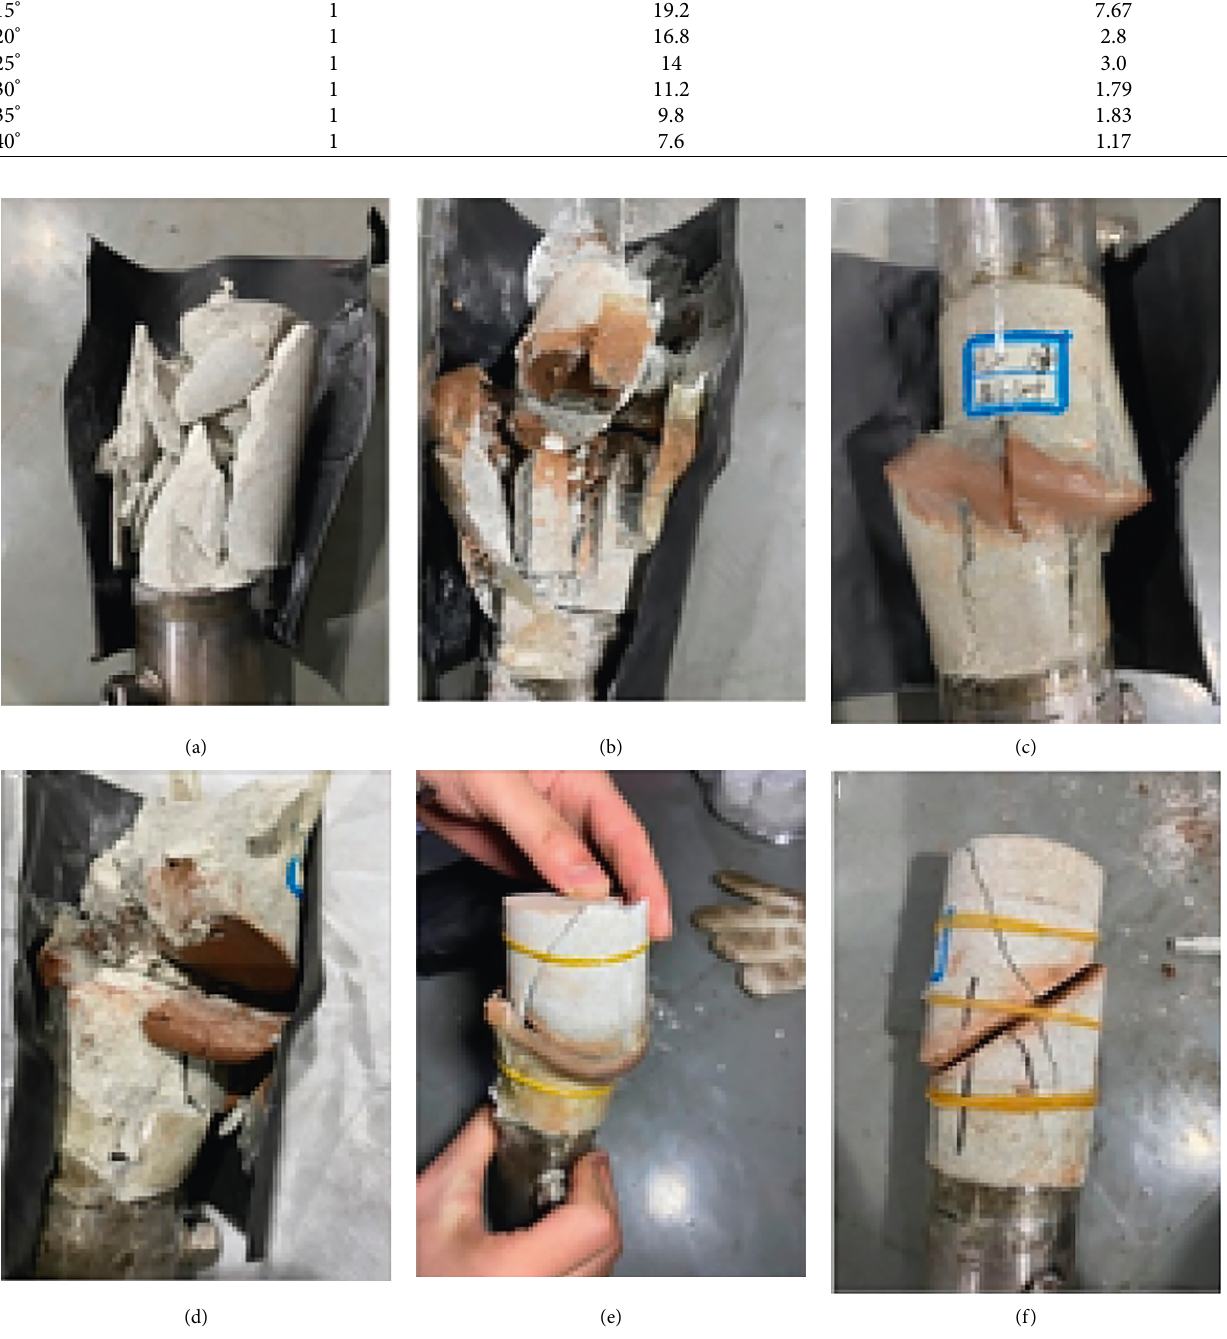
Figure 6: Fragmentation characteristics of mudstone specimens with different joint plane angles: (a) standard mudstone specimen, (b) joint plane angle of 15 ° , (c) joint plane angle of 20 ° , (d) joint plane angle of 25 ° , (e) joint plane angle of 35 ° , and (f) joint plane angle of 40 °